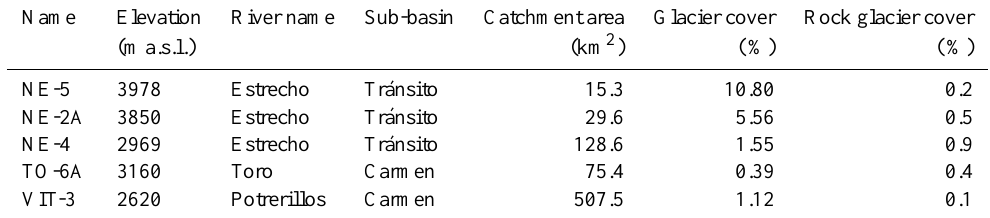
Table 1. Automatic stream gage stations characteristics (2003/2004–2007/2008). Name Elevation River name Sub-basin Catchment area Glacier